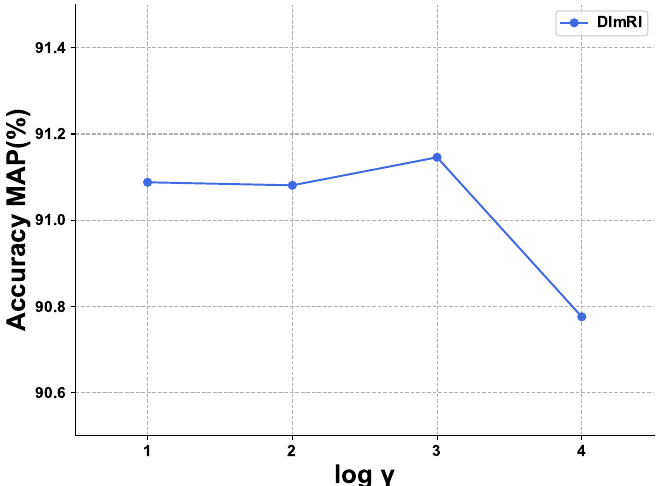
Figure 6. The figure shows the effect of γ on the MAP score using our DlmRl.